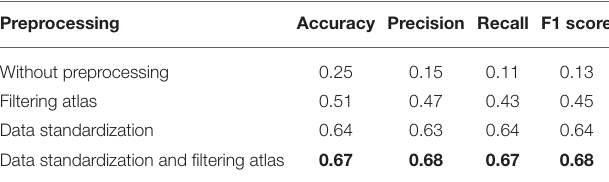
TABLE 3 | Effect of data preprocessing on the